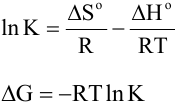
Table 8. Thermodynamic parameters for the adsorption of MB dye Figure 8. (a) Plot of log K versus 1/T for sorption of MB onto Fe 3 O 4 /AC nanocomposite